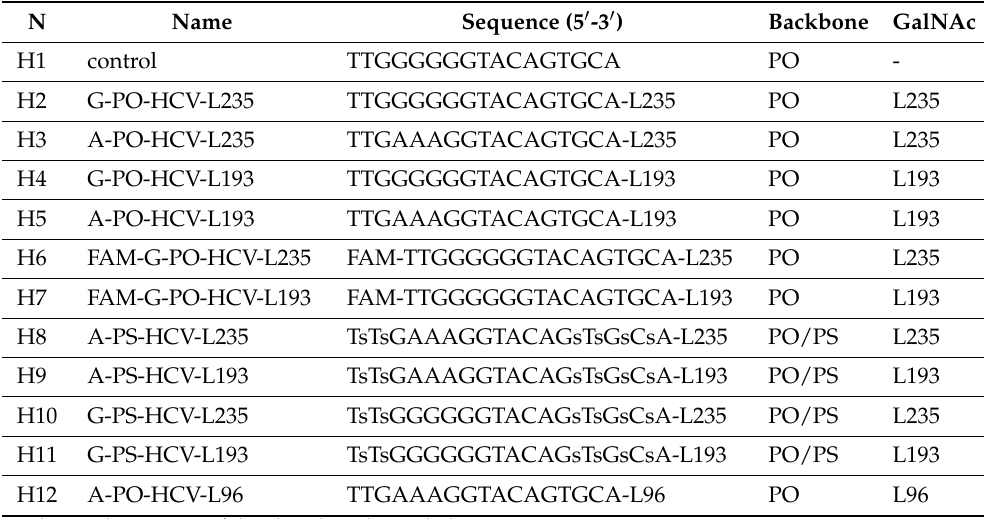
Table 1. Oligonucleotide derivatives from 17 mer antiviral sequence.